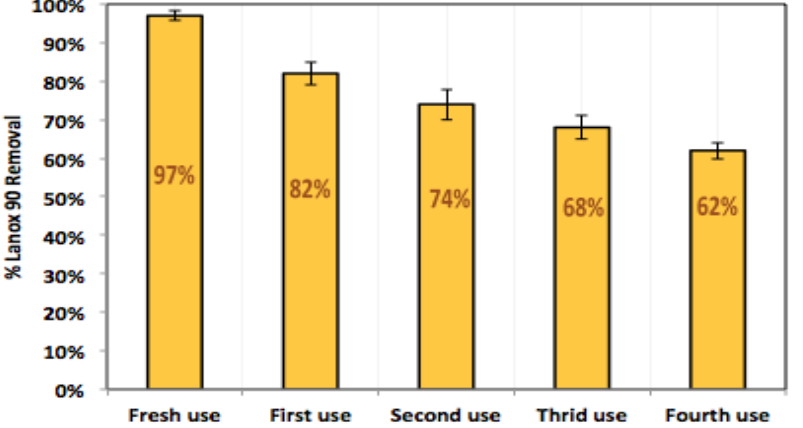
Figure 12. Catalyst ’s recyclability activity on Lanox 90 oxidation. Figure 12. Catalyst’s recyclability activity on Lanox 90